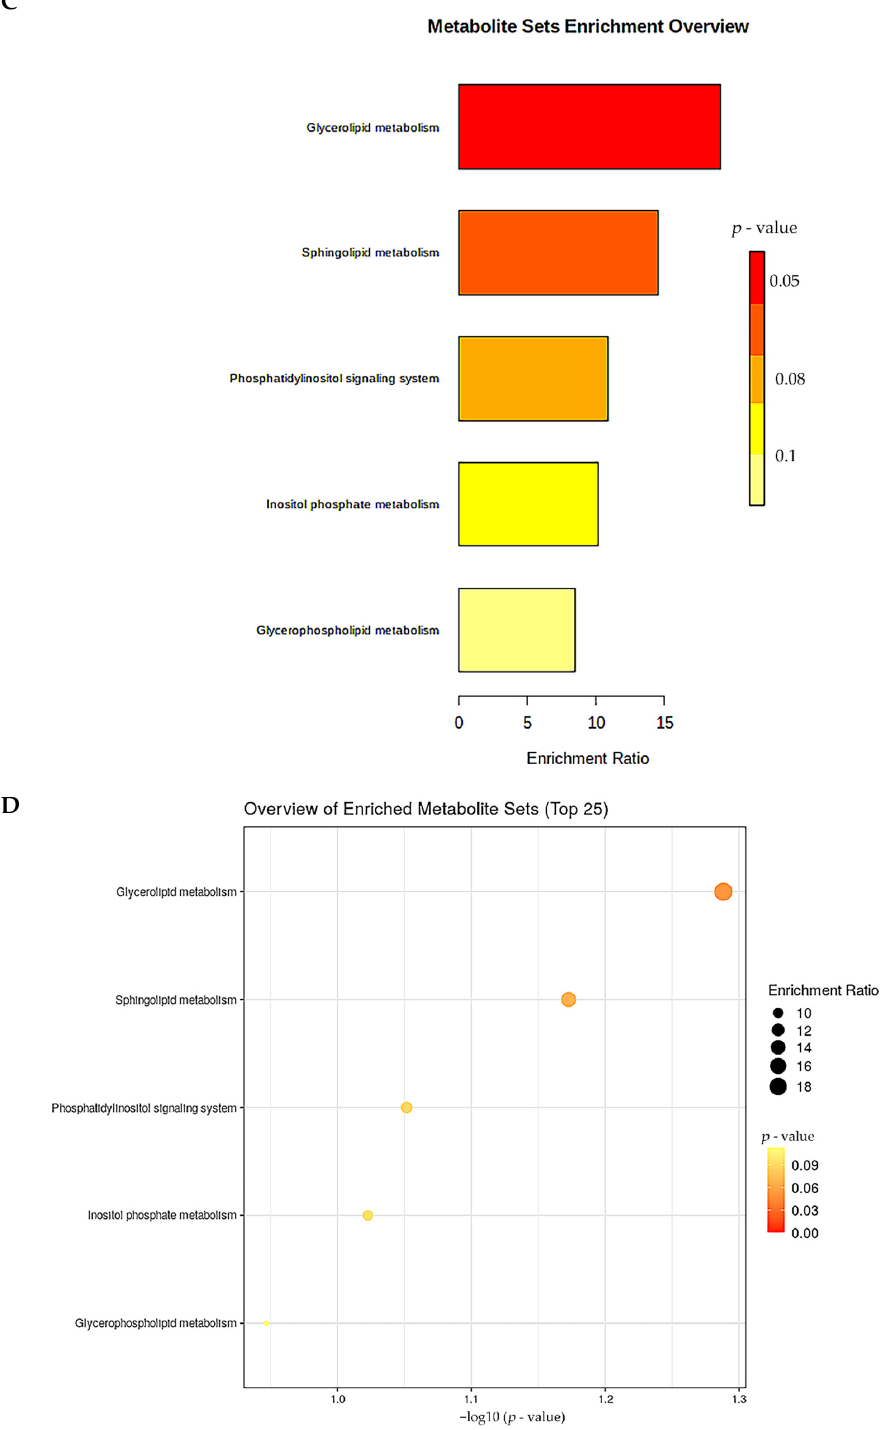
Figure 7. Overview of the main classes and pathways of KEGG. ( A ) KEGG subclass categories of differential metabolites. ( B ) KEGG subclass enrichment of differential metabolites. ( C ) KEGG pathway categories of differential metabolites. ( D ) KEGG pathway enrichment of differential metabolites. The abscissa represents the rich factor corresponding to each main class. The ordinate is the class name. The colorbar is p value. The redder it is, the more